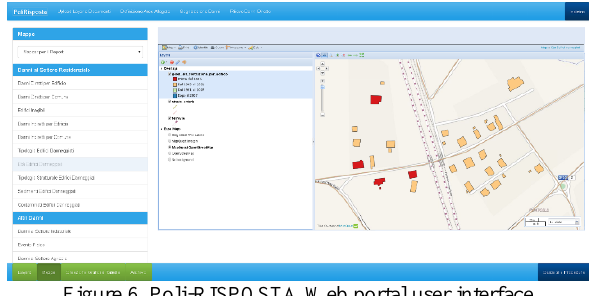
Figure 6. Poli-RISPOSTA Web portal user